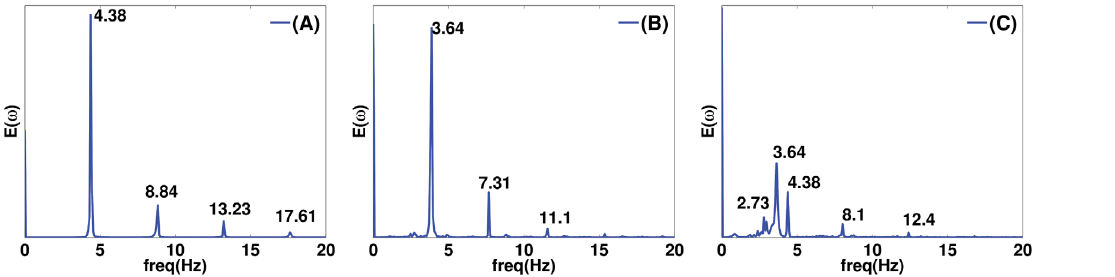
Fig 16. Averaged power spectra of the time series of V m of Fig 15 from four representative points located near the four corners in the domain. (A) The power spectrum (E( ω )) of the free rotating spiral indicates a periodic motion with a fundamental frequency of 4.38 Hz. (B) The spectrum of the spiral anchored to the clump with R = 2 cm also indicates a periodic motion with the fundamental frequency reduced to 3.64 Hz. (C) The spiral anchored to the clump of radius R = 3 cm shows a quasiperiodic motion. The peaks in (C) can be indexed as n 1 ω 1 + n 2 ω 2 , where n 1 and n 2 are integers, and ω 1 ’ 2.73 Hz and ω 2 ’ 3.64